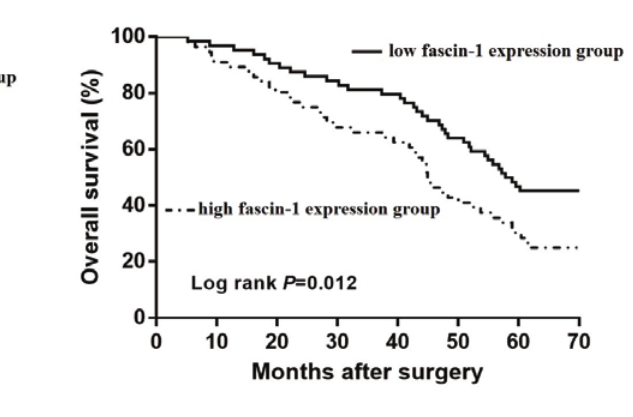
Figure 5: The fascin-1 protein expression status and overall survival of glioma